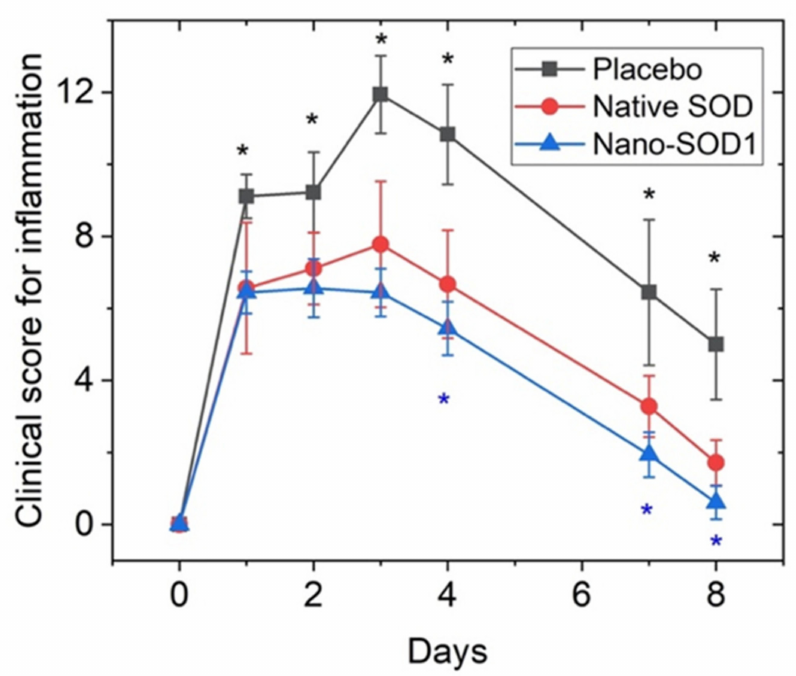
Figure 6. The effect of topical instillations of SOD1 and Nano-SOD1 on the development of inflam- matory signs in rabbits with acute uveitis. Clinical scores for all signs of uveitis in each eye were summed up and expressed as mean ± SEM. * p < 0.05 (Mann–Whitney